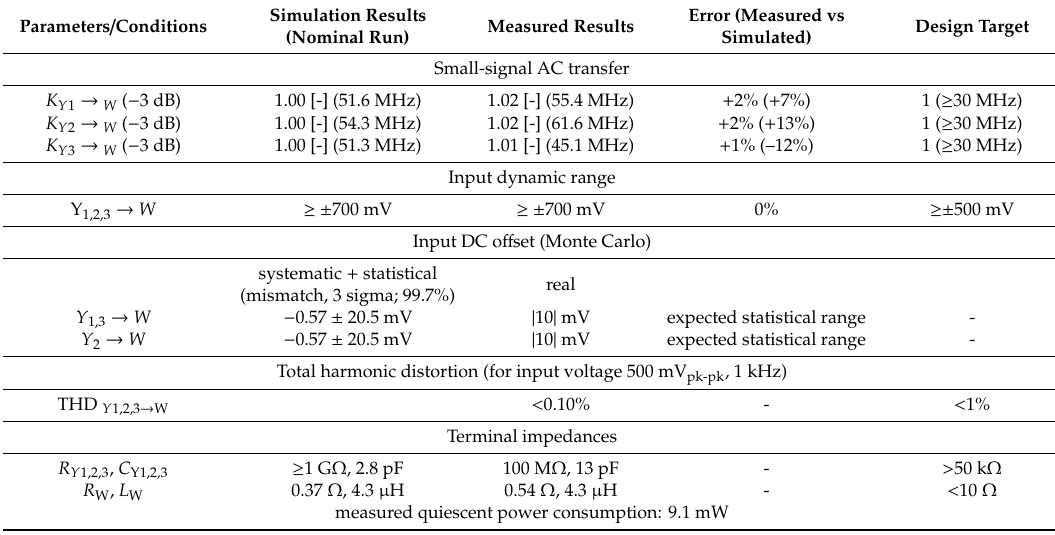
Table A1. Summary of simulated and measured performances of the VDDB cell.